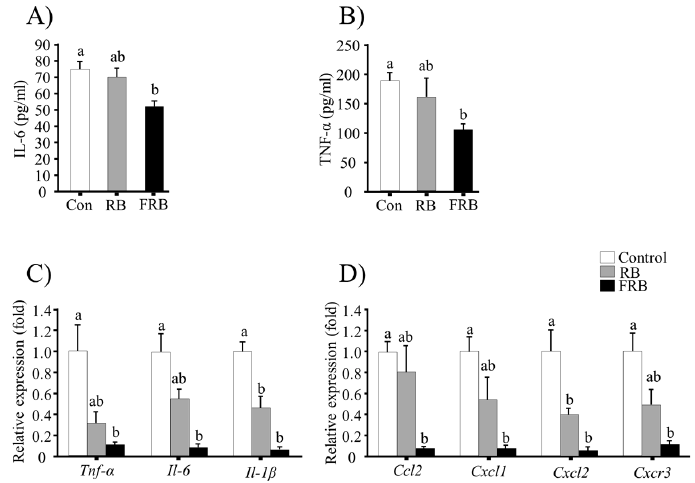
Figure 5. Evaluation of the anti-inflammatory effects of fermented rice bran (FRB). Serum levels of pro-inflammatory cytokines ( A ) TNF- α and ( B ) IL-6; ( C ) relative expression of colonic pro-inflammatory cytokine genes; and ( D ) relative expression of chemokine and chemokine receptor genes in the colon. The mRNA levels were normalized to the expression of Eef1a1 gene. The values are expressed as the mean ± SEM ( n = 4); One-way ANOVA was done followed by Tukey’s multiple comparison test. Different letters indicate significant difference. Con, control; RB, rice